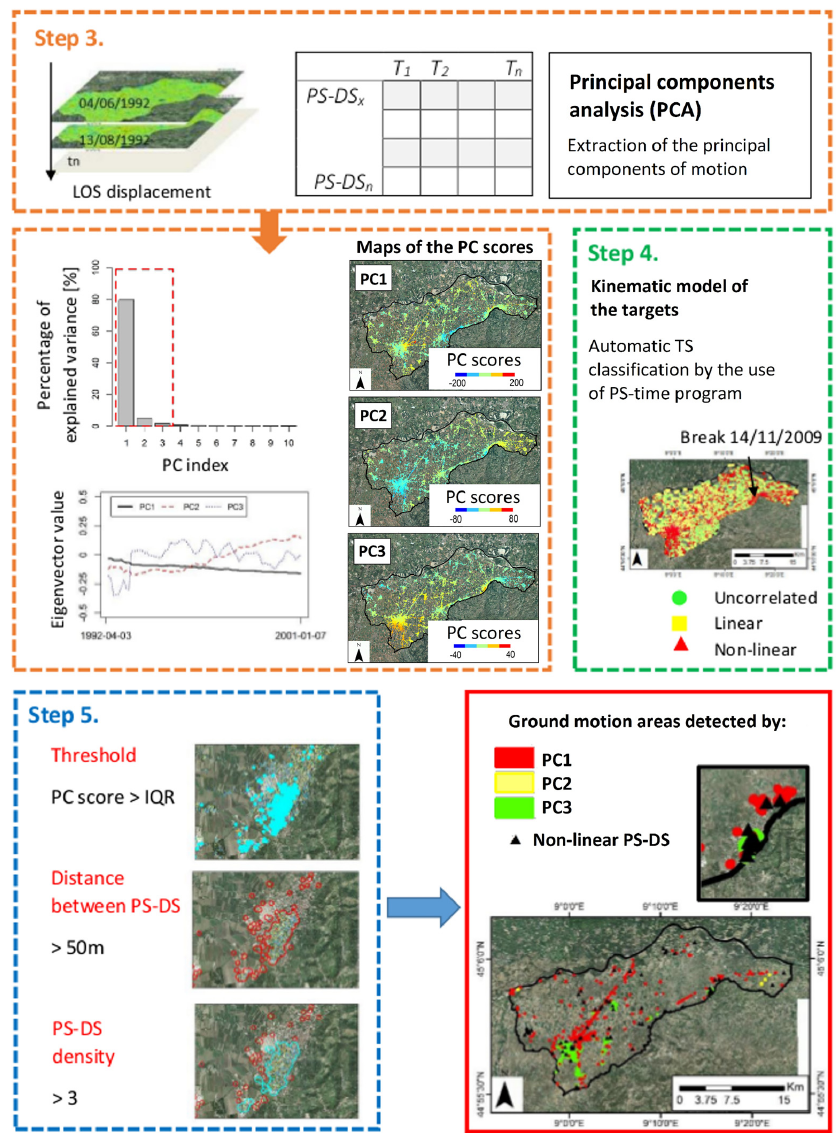
Figure 4. Flowchart of the phase II in the methodological approach to identify ground motion areas.